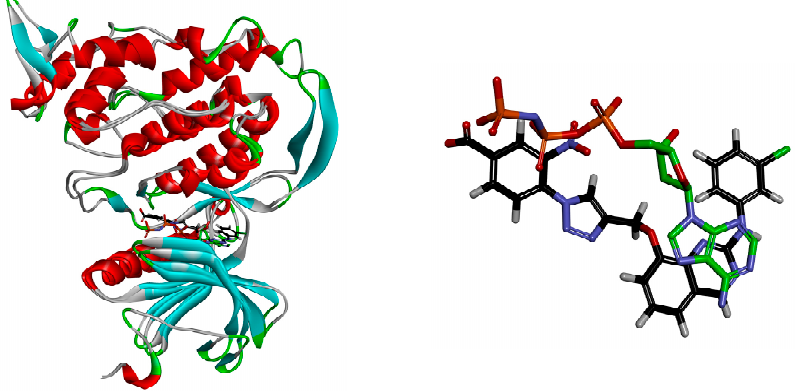
Figure 4. Superimposition of DYRK1A cocrystallized with ANP (carbons atoms in green on the right) and CLK1 withdocked 12g (black carbon atoms on the right).